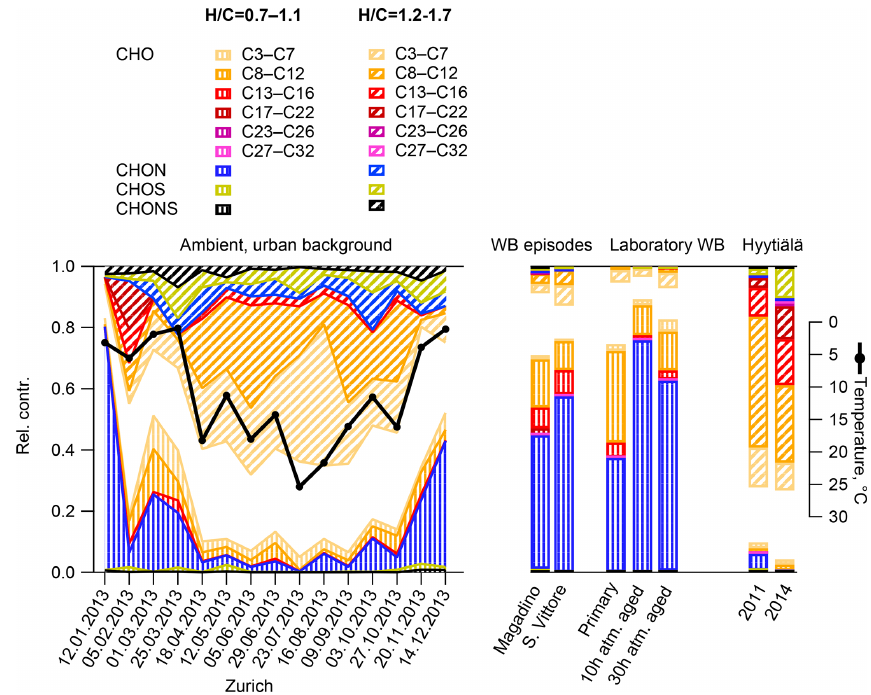
Figure 12. Relative contributions of different compound classes to the signal of compounds, with 0 . 7 ≤ H / C ≤ 1 . 1 as a surrogate for wood- burning emissions and 1 . 2 ≤ H / C ≤ 1 . 7 as a surrogate for biogenic